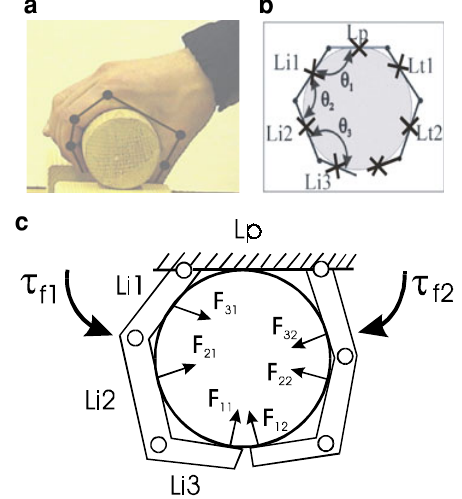
Figure 8 A scheme for human-like grasp: (a) the reference grasp test; (b) location of contacts; and (c) a model for grasping forces.